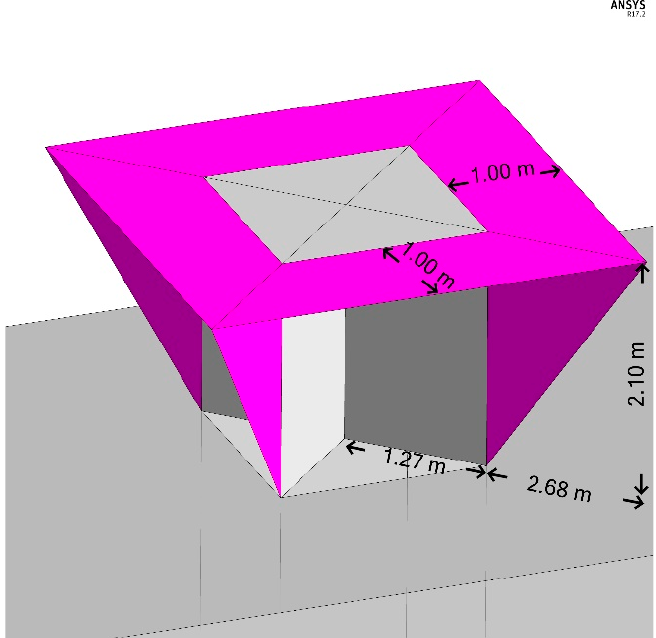
Figure 15. Wind catcher version ‘empty + modified deflector’; dimensions of the enlarged sidewalls (deflectors) of the wind catcher version ‘empty’.